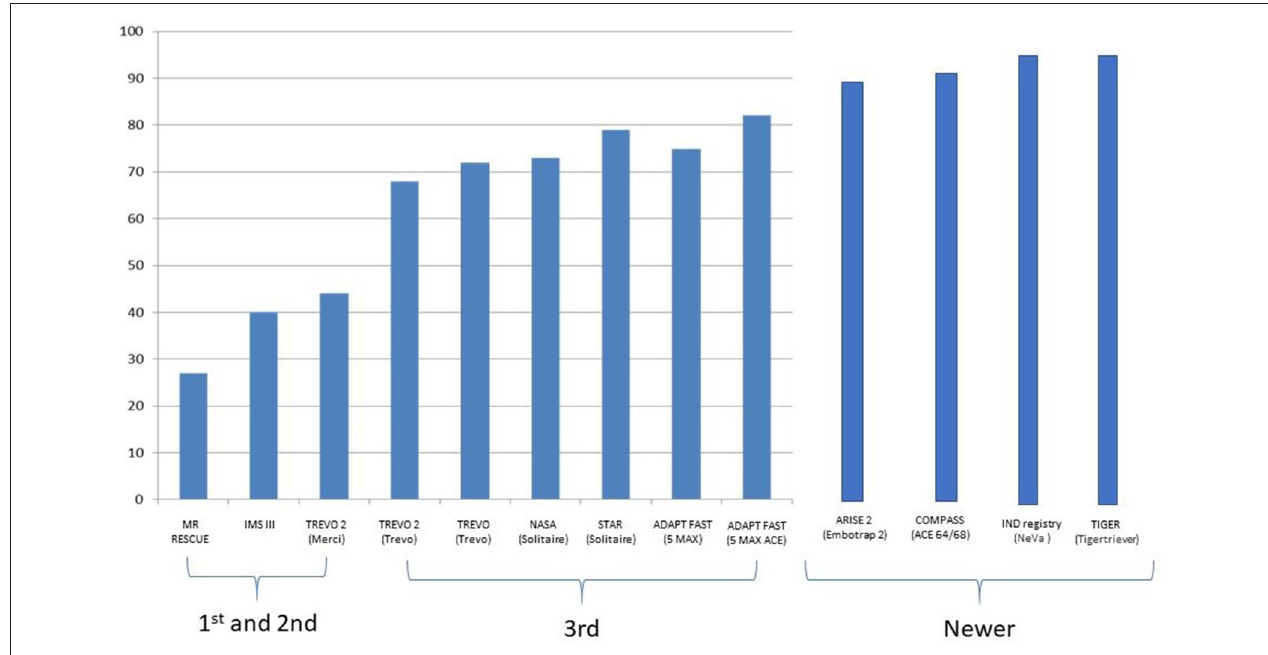
FIGURE 7 | Increasing MTICI 2b-3 reperfusions rates being reported with each successive generation of